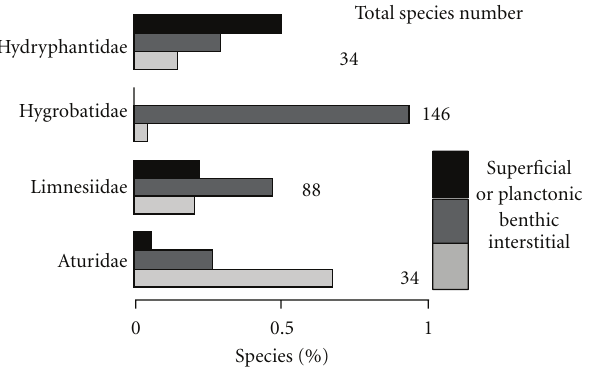
Figure 3: Percent of the main ecological forms in the four most diverse Hydrachnidia